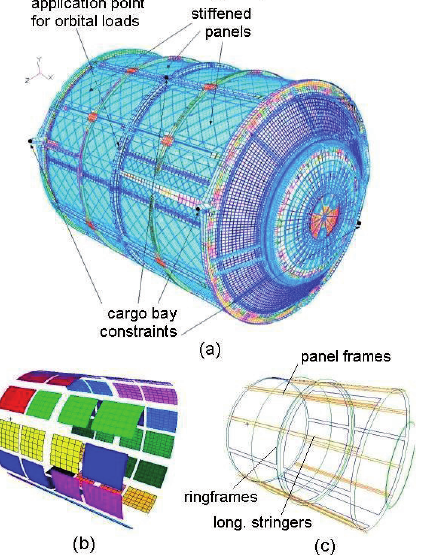
Fig. 6. Space structure model (a) with the panels (b) and the bar elements (c) details.